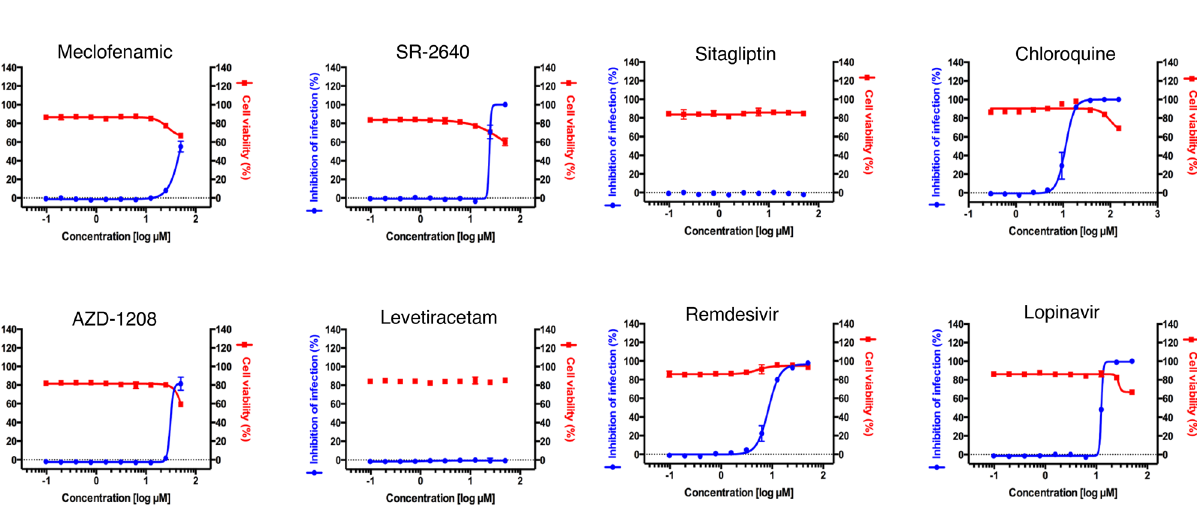
Figure 2. Viral inhibition and cell viability curves used to generate Table 2.